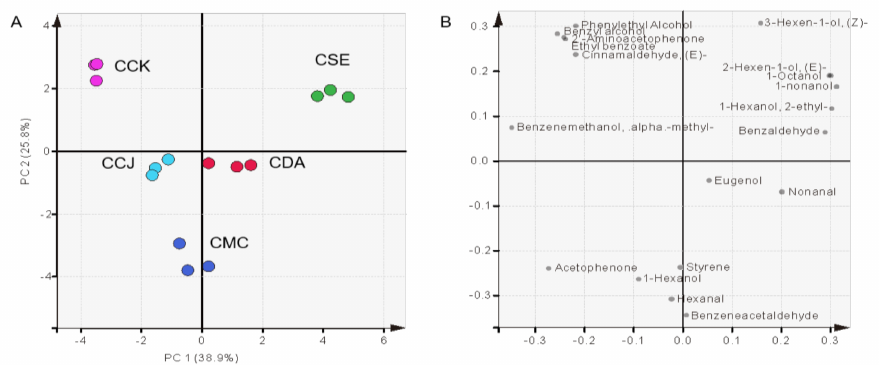
Figure 3. Score ( A ) and loading ( B ) plot of volatile compounds according to Castanea spp. Abbreviations; CCK, C. crenata (Korean cultivar ‘Mipung’); CCJ, C. crenata (Japanese cultivar ‘Ungi’); CDA, C. dentata (American chestnut); CMC, C. mollissima (Chinese chestnut); CSE, C. sativa (European